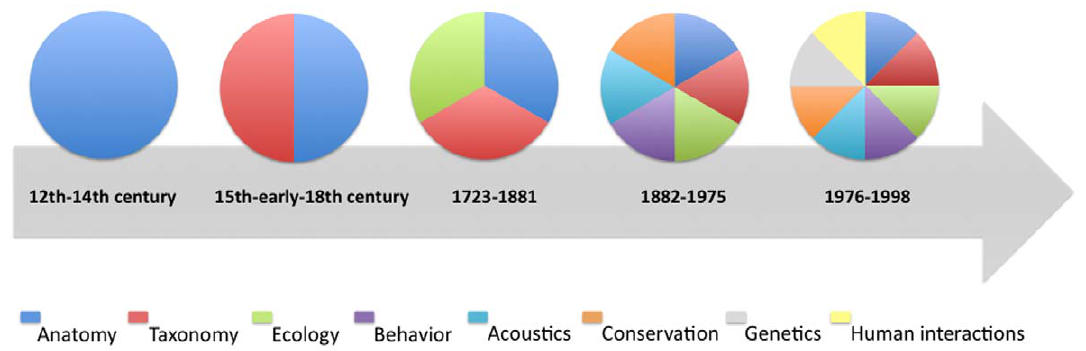
Figure 5. Number of different disciplines related to cetaceans throughout time (n=8).